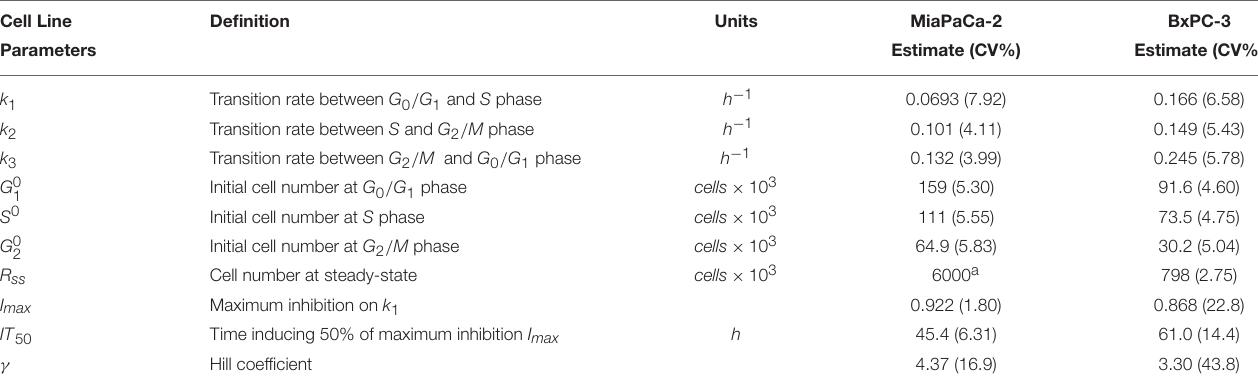
TABLE 2 | Pharmacodynamic model parameter estimates for two cell lines. Parameters were obtained after fitting to the cell cycle base model shown in Figure